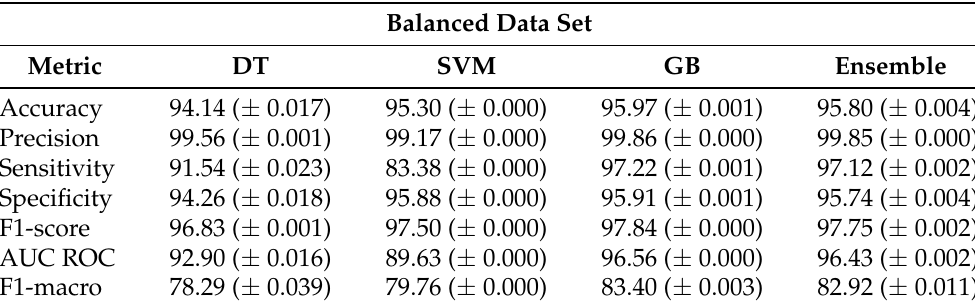
Table 6. Results of metrics (in %) and associated standard deviation for model testing using the balanced data